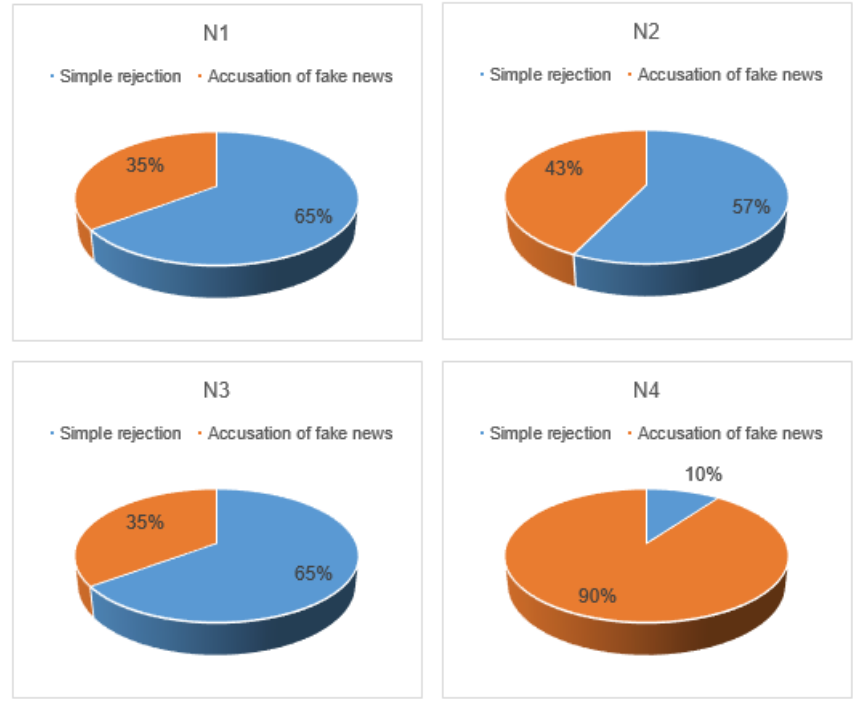
Figure 3. Comments from the social audience calling out Mediterráneo Digital as a source of